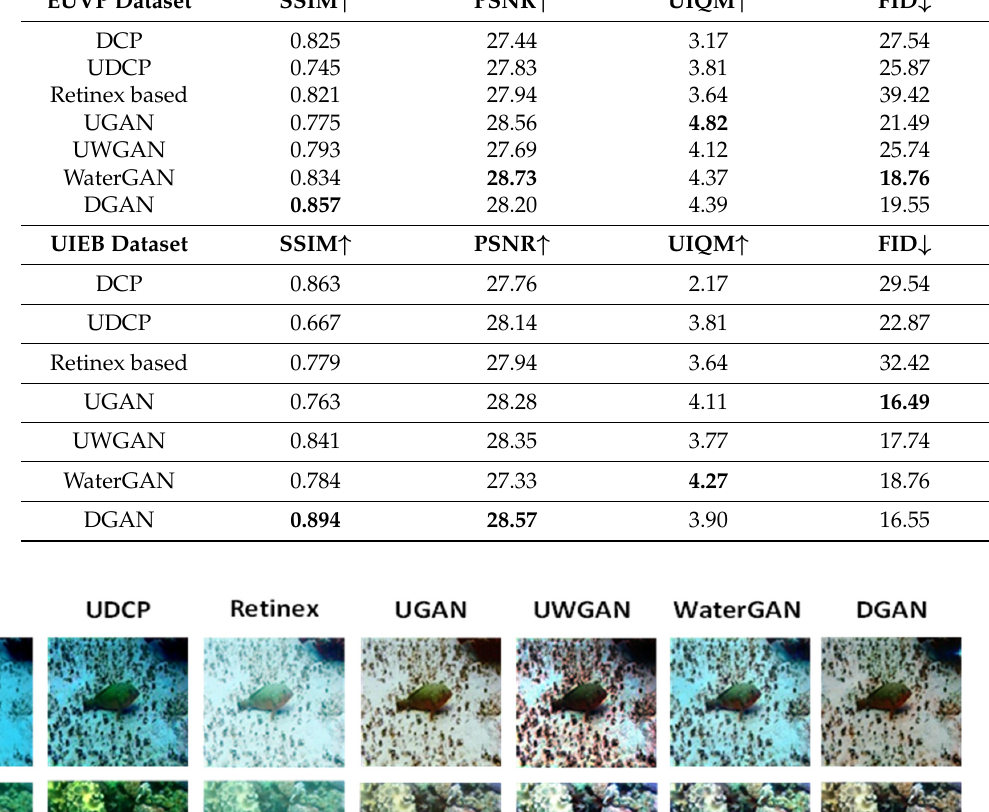
Table 1. Comparison of different algorithms on two different datasets.